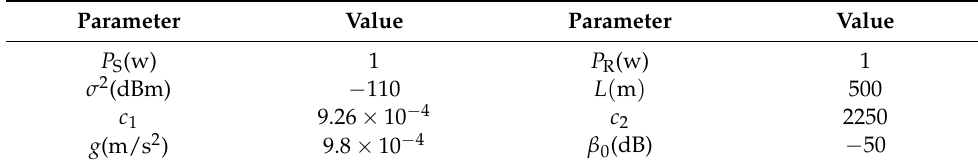
Table 1. Simulation